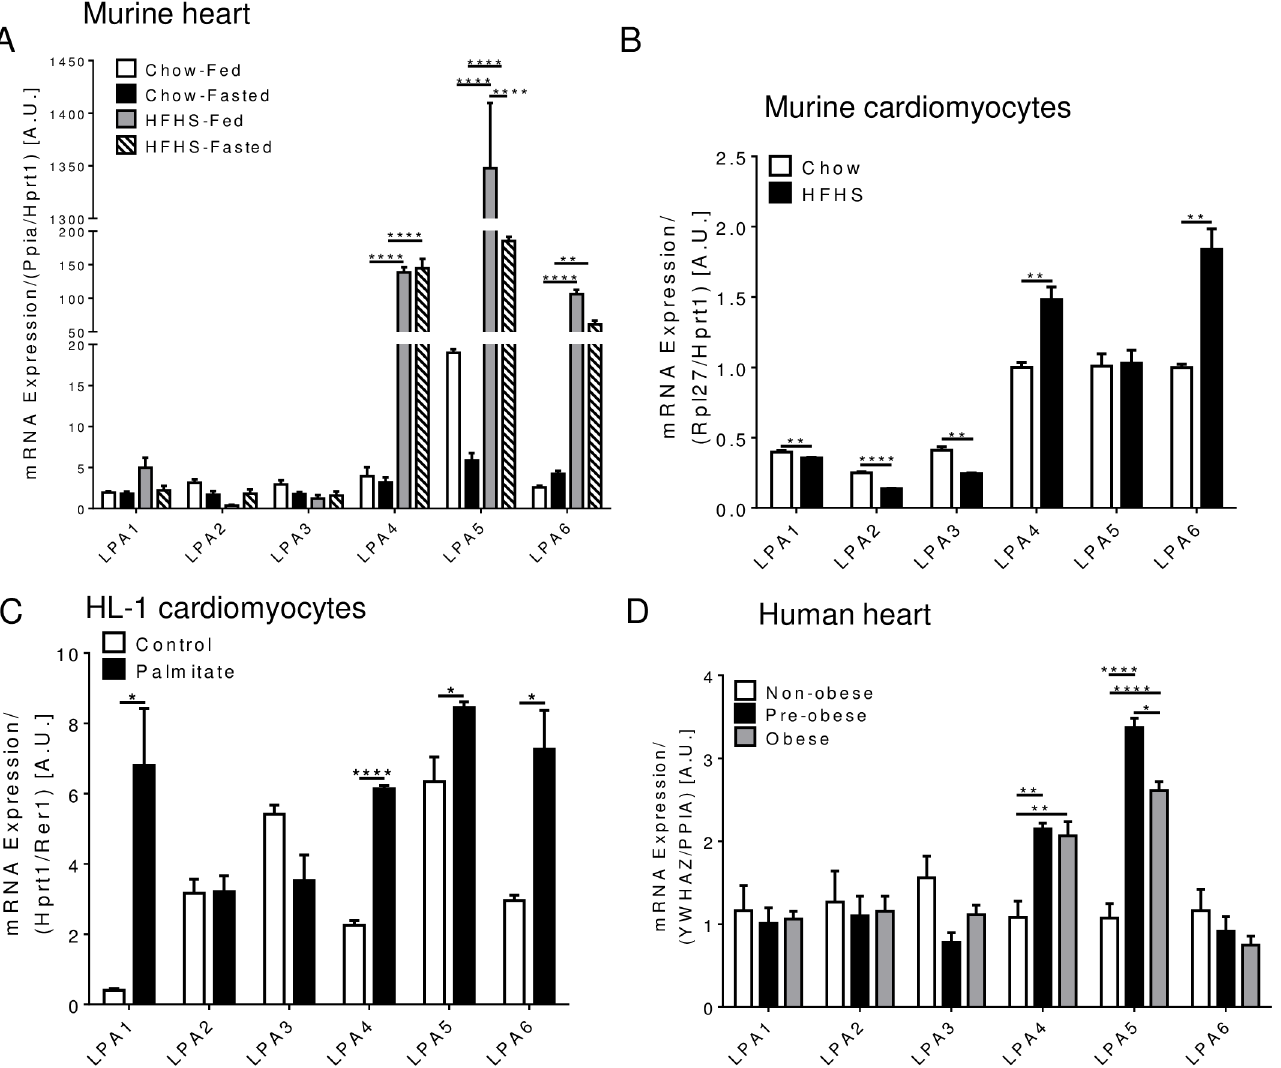
Fig 2. LPA receptor mRNA levels in myocardialtissue and cells. A) LPA1-6 mRNA levels in ventriclesfrom chow and HFHS-fed mice in fed and 16-h fasted states (n = 5). B) LPA1-6 mRNA levels in cardiomyocytes isolatedfrom chow and HFHS-fed mice (n = 3). C) LPA1-6 mRNA levels in